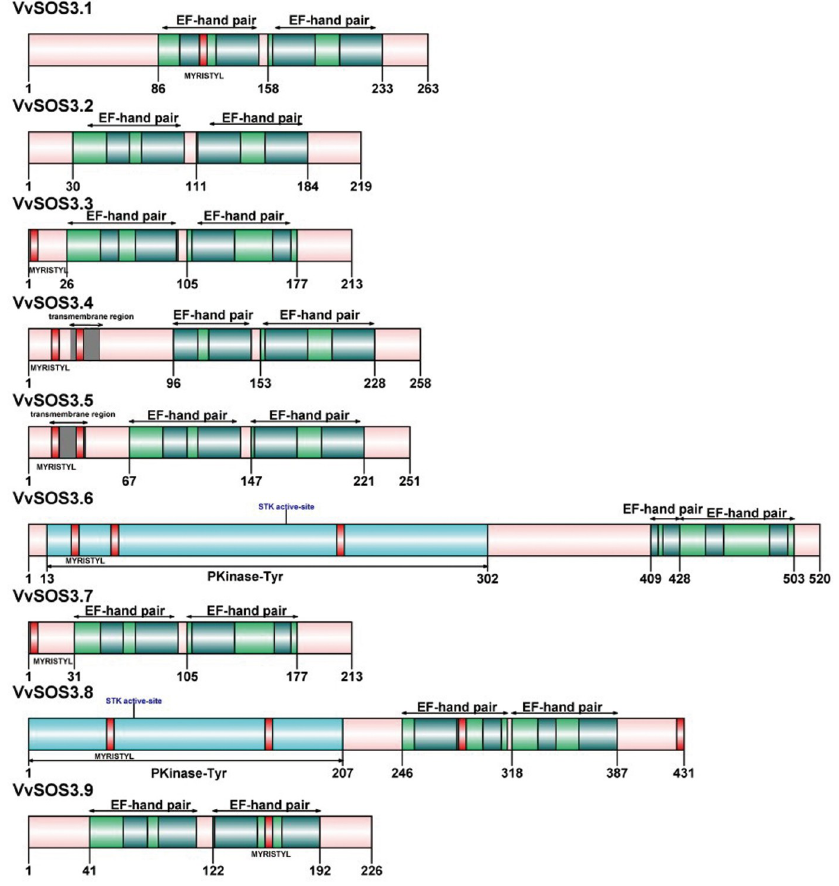
Fig 1. Diagrammatic illustration of the composition and domain distribution of VviSOS3 proteins. The domains are displayed in different colored boxes: gray, transmembrane region; blue, protein kinase-Tyr (Pkinase-Tyr); green, EF-hand; red,